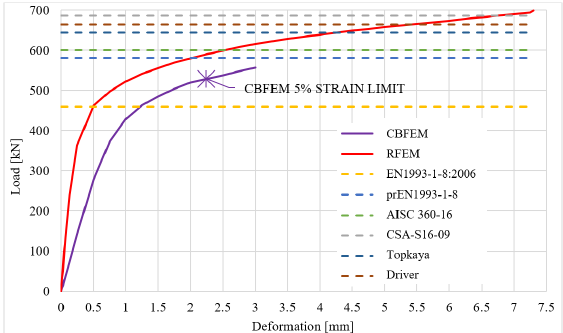
Figure 14. Comparison of RFEM, CBFEM and analytical models for specimen T1. Metals 2021 , 11 , x FOR PEER REVIEW